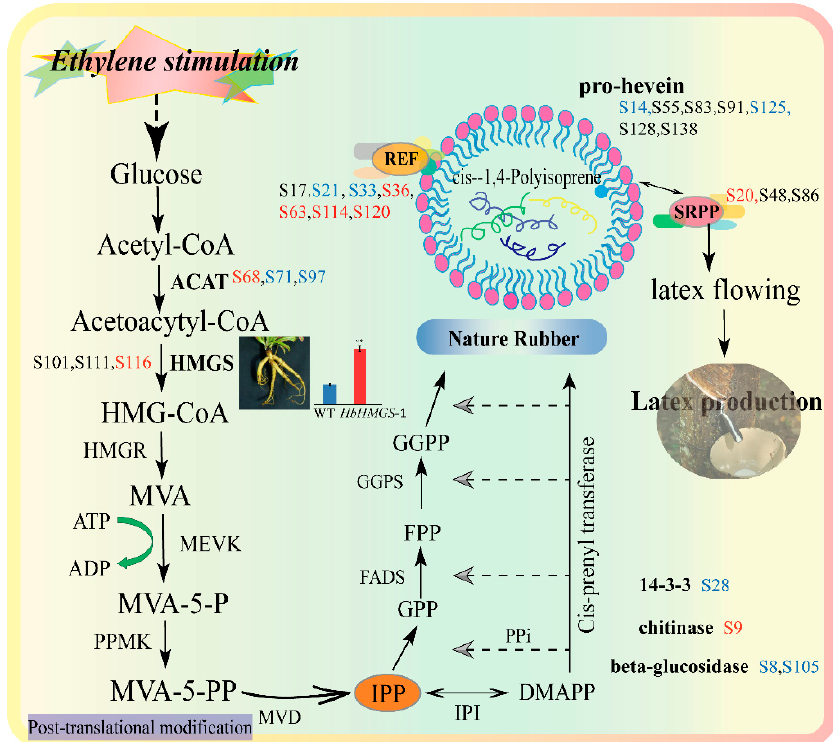
Figure 7. Schematic diagram of the melavonate (MVA) pathway regulated by natural rubber biosynthesis. The identified eight glycosylation proteins in the natural rubber (NR) biosynthesis pathway are highlighted. Among them, seven proteins were identified from different spots (S-) in the 2-DE gels for rubber latex collected from the water- and ethylene-treated rubber trees on the third and fifth day. The red number refers to the up-regulated protein spots, and the blue number stands for the down-regulated protein spots after ethylene stimulation (Table S2).